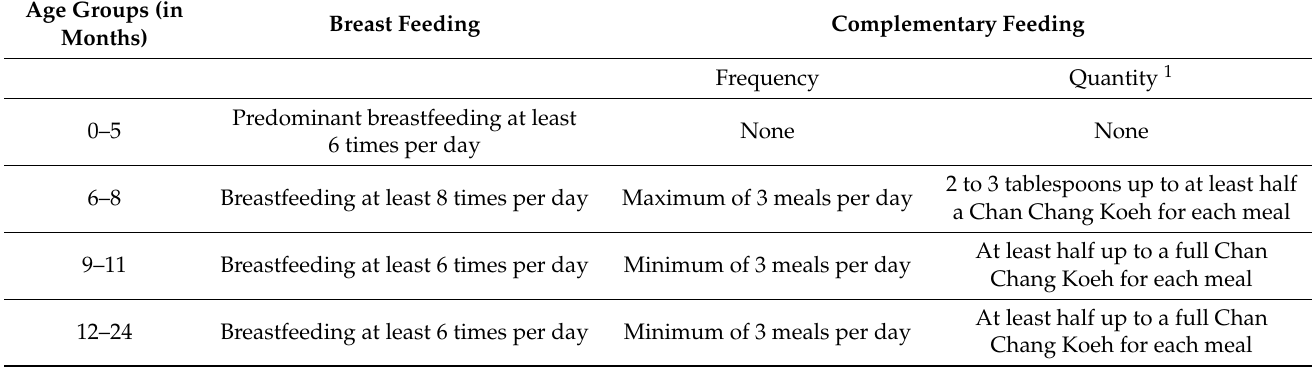
Table 2. The construction of age-appropriate daily feeding